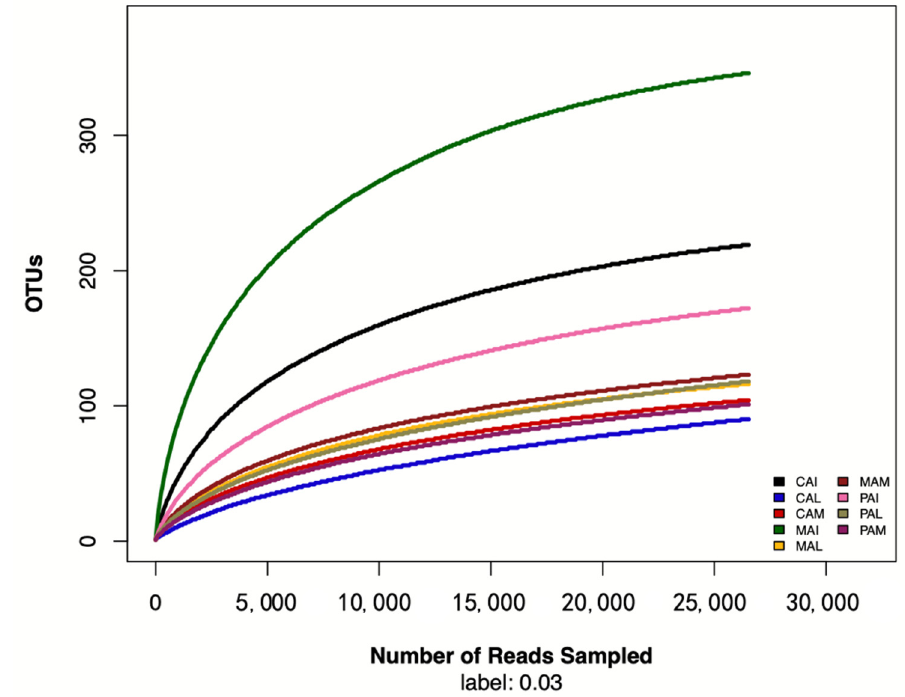
Figure 1. Sample dilution curve. CAI is the pre-fermentation Cabernet Sauvignon, CAM is the mid-fermentation Cabernet Sauvignon, and CAL is the late fermentation Cabernet Sauvignon. MAI is the pre-fermentation Matheran, MAM is the mid-fermentation Matheran, and MAL is the late fermentation Matheran. PAI is the pre-fermentation Cabernet Franc, PAM is the mid-fermentation Cabernet Franc, and PAL is the late fermentation Cabernet Franc.